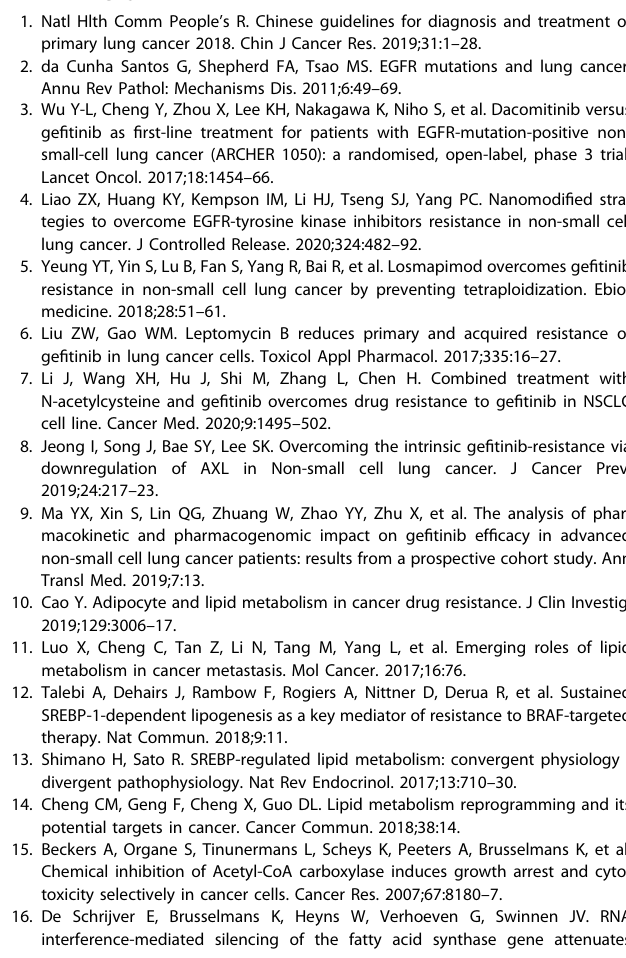
Fig. 5 Fatostatin enhances the effect of ge fi tinib in PC9/GR xenograft model. Tumor-bearing BALB/c nude mice were assigned randomly into four groups ( n = 6 per group) and administered vehicle, Gef (25 mg/kg), Fato (20 mg/kg) or a combination of Gef and Fato for 17 d (daily by oral gavage). A Tumor volume of PC9/GR xenografts in each treatment group. B Tumor from nude mice in each treatment group. C Tumor weight (mg) in four groups. D The mRNA levels of SREBP1, FASN , and SCD in tumor tissues were determined by RT-qPCR ( n = 4). E The protein expression of SREBP1, mSREBP1, FASN, and SCD in tumor tissues were analyzed by western blot and the corresponding results were quanti fi ed by the density of immunoblotting ( n = 3). F Immunohistochemical analysis of Ki67 in tumors and quanti fi cation were performed by Image J ( n = 3). Scale bars indicate 100 μ m. G Lipidomic analysis on Gef and Gef + Fato group in positive and negative ion modes, respectively. PCA and OPLS-DA score plots of lipidomic pro fi les obtained from LC-MS/MS. H Comparison of the changed lipids between Gef and Gef + Fato group. Data are expressed as the mean ± SD. *P < 0.05, **P < 0.01, ***P < 0.001 compared with control. # P < 0.05, ## P < 0.01, ### P < 0.001 compared with ge fi